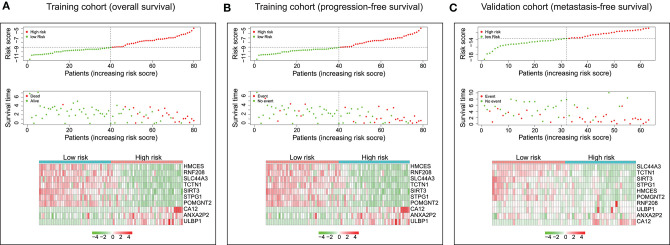
Characteristics of the ten-gene signature. (Upper and middle) The distribution of ten-gene risk score and patients' survival time, and events for training cohort based on overall survival (A), training cohort based on progression-free survival (B), and validation cohort based on metastasis-free survival (C). According to the median risk score, patients were divided into low-risk and high-risk groups. The left side of the black dotted line is the low-risk group, and the right side is the high-risk group. (Bottom) Heatmaps were plotted to illustrate the ten-gene expression profiles in the training cohort based on overall survival (A), training cohort based on progression-free survival (B), and validation cohort based on metastasis-free survival (C).